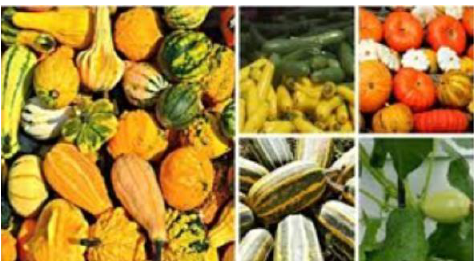
Fig 1. Pictures of some cucurbitaceae family